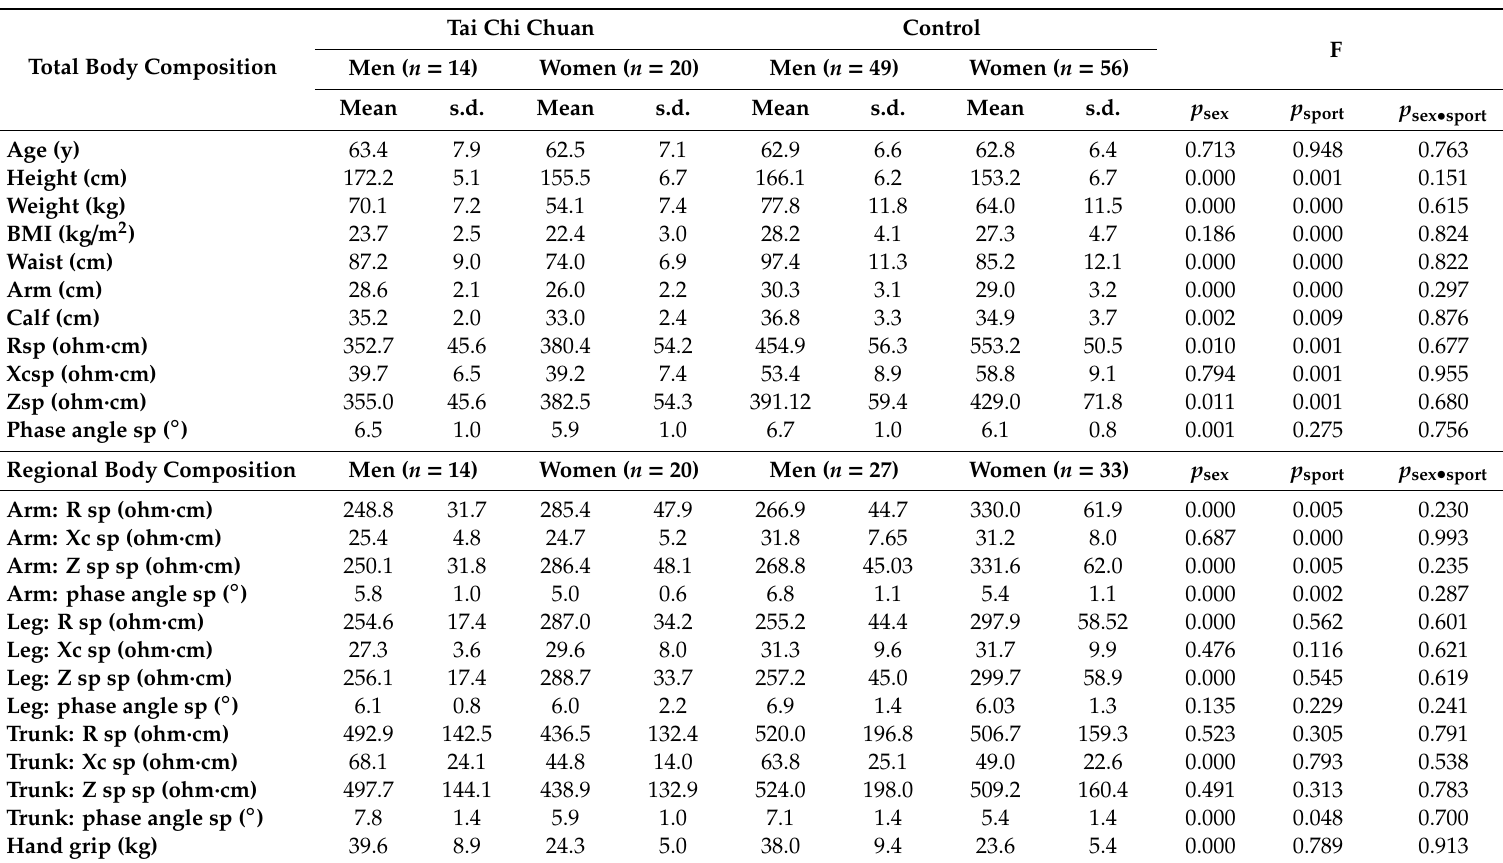
Table 1. Anthropometry, total and regional body composition in the Tai Chi Chuan group. Two-way ANOVA for the comparison between sexes and with the control sample of healthy Italian